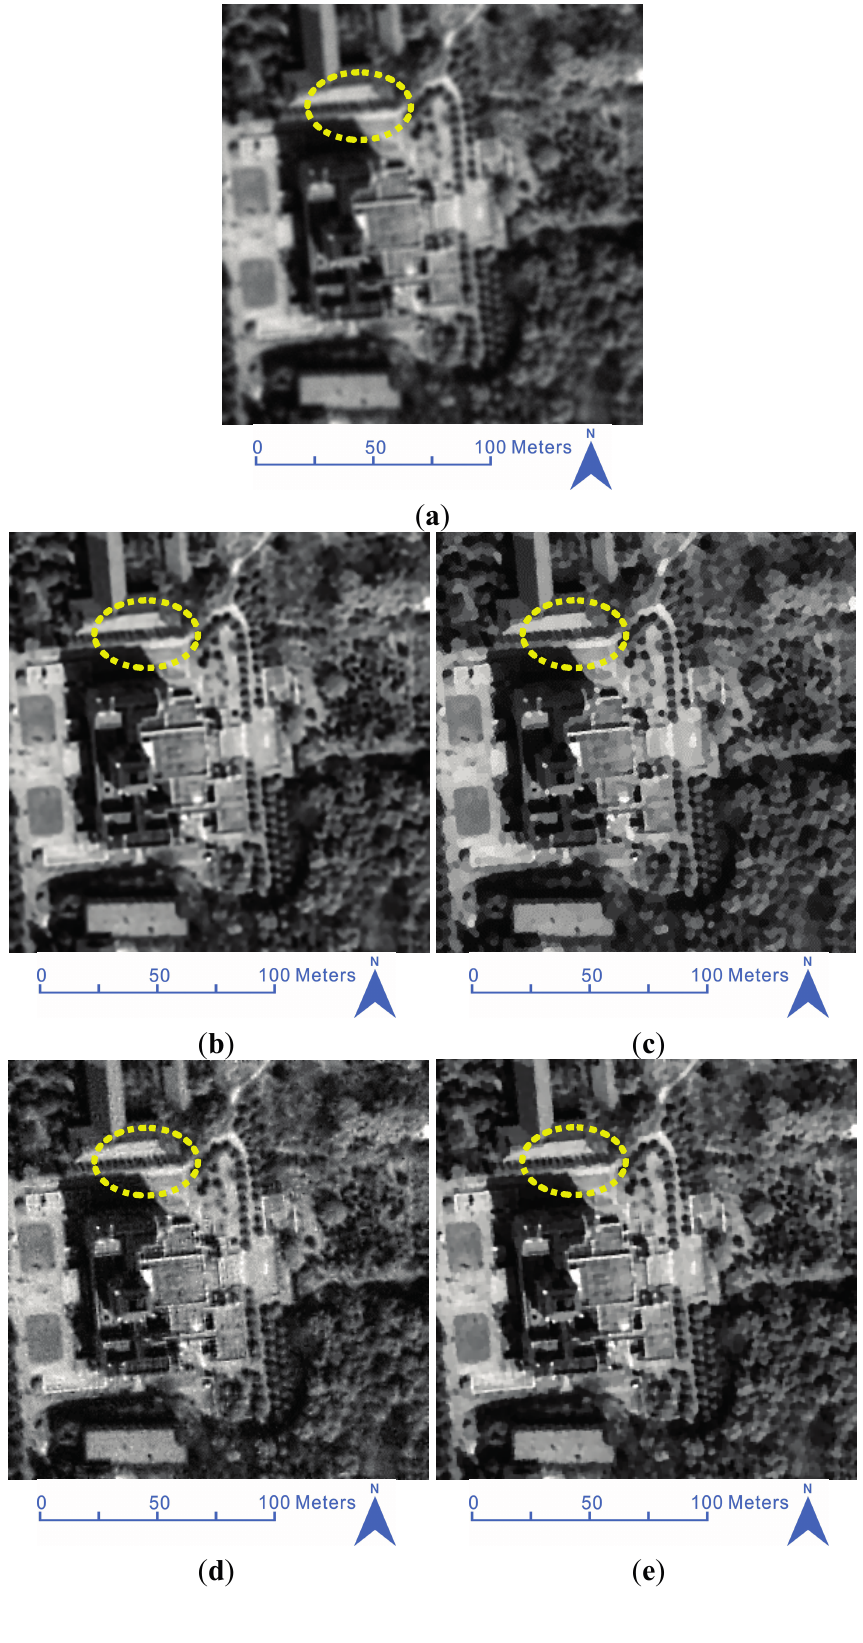
Figure 7. Comparison of the results for the QuickBird image in the noisy case: ( a ) degraded image by a 5 × 5 truncated Gaussian PSF, and WGN with a variance of 3; ( b ) restored image of the MLO method; ( c ) restored image of the AM-Sparse method; ( d ) restored image of the AM-HMRF method; ( e ) restored image of the AM-KEdge